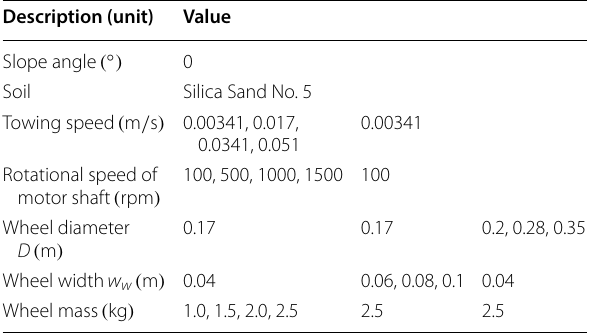
Table 2 Experimental conditions for the locked‑wheel towing test